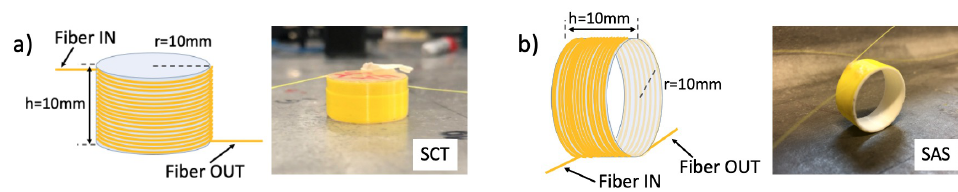
Figure 2. Fiber optic ultrasonic transducer ( a ) quartz cylinder (SCT) and ( b ) 3D-printed ring